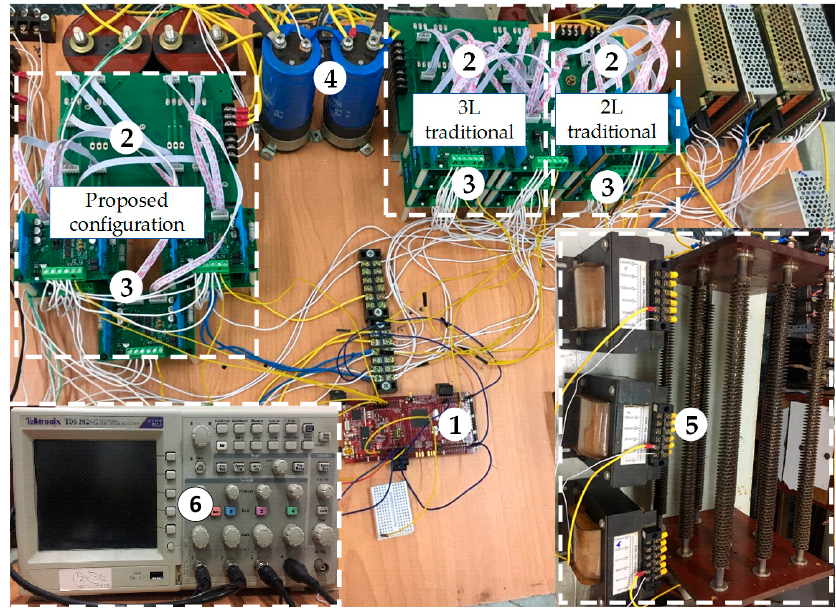
Figure 18. Experimental model in the laboratory.